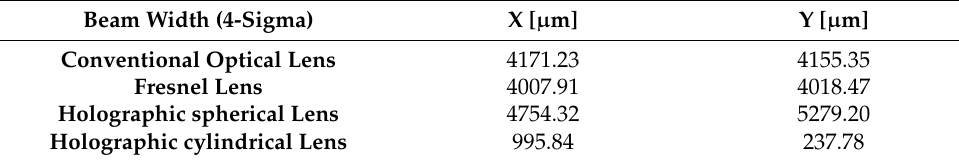
Table 3. Beam width four sigma evaluated for four different lenses. Beam Width (4-Sigma) Conventional Optical Lens